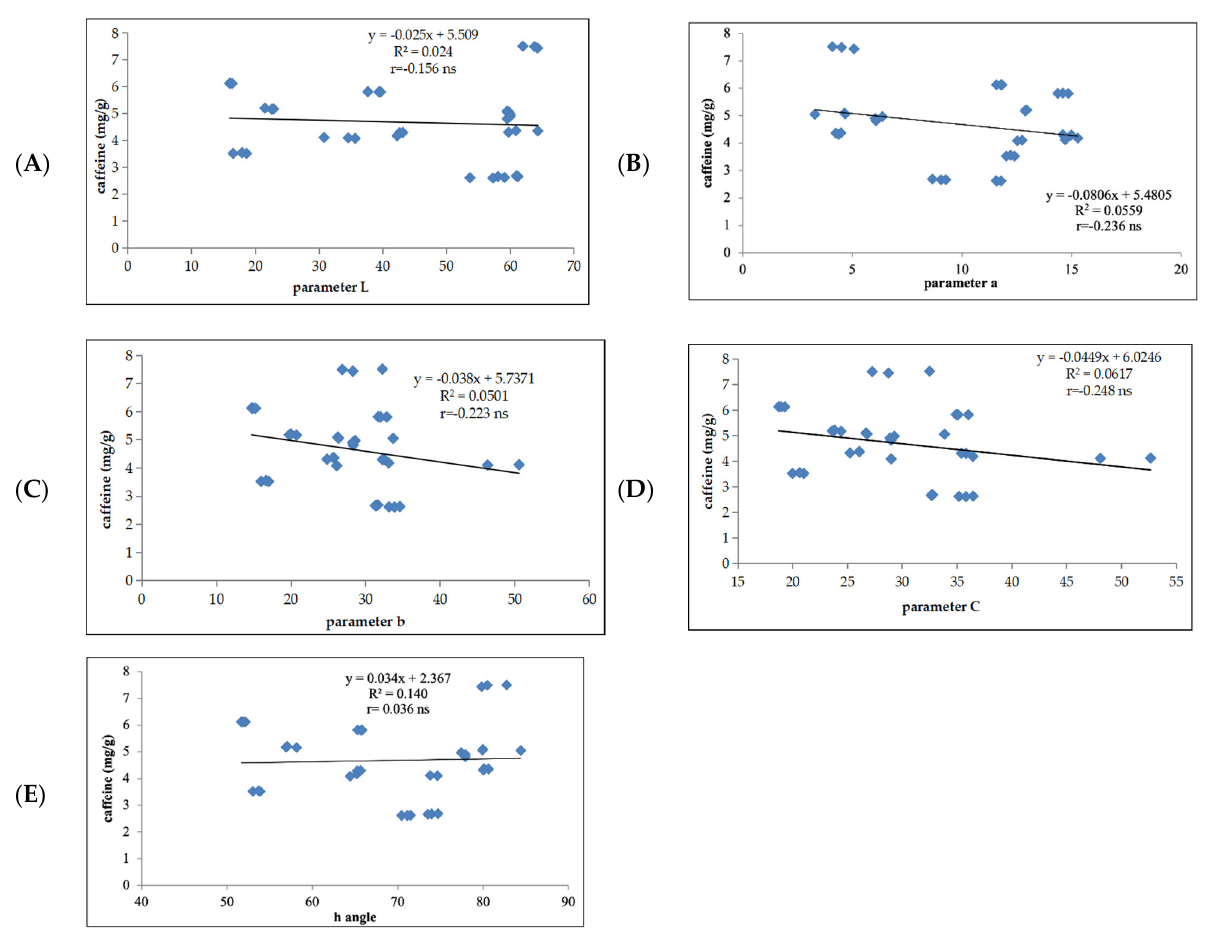
Figure 4. The correlation between ground roast coffee color ( A ) L*, ( B ) a*, ( C ) b*, and ( D ) C*, and ( E ) hue angle with caffeine content. (ns: no significant).